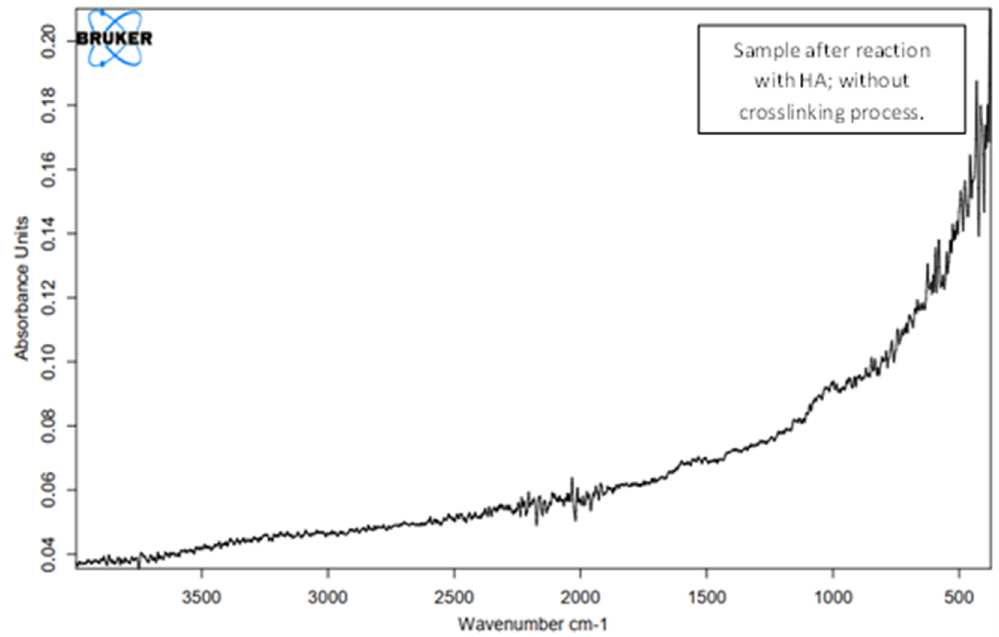
Figure 11. IR spectrum for a carbon nonwoven fabric after treatment with hyaluronic acid without the cross-linking process.